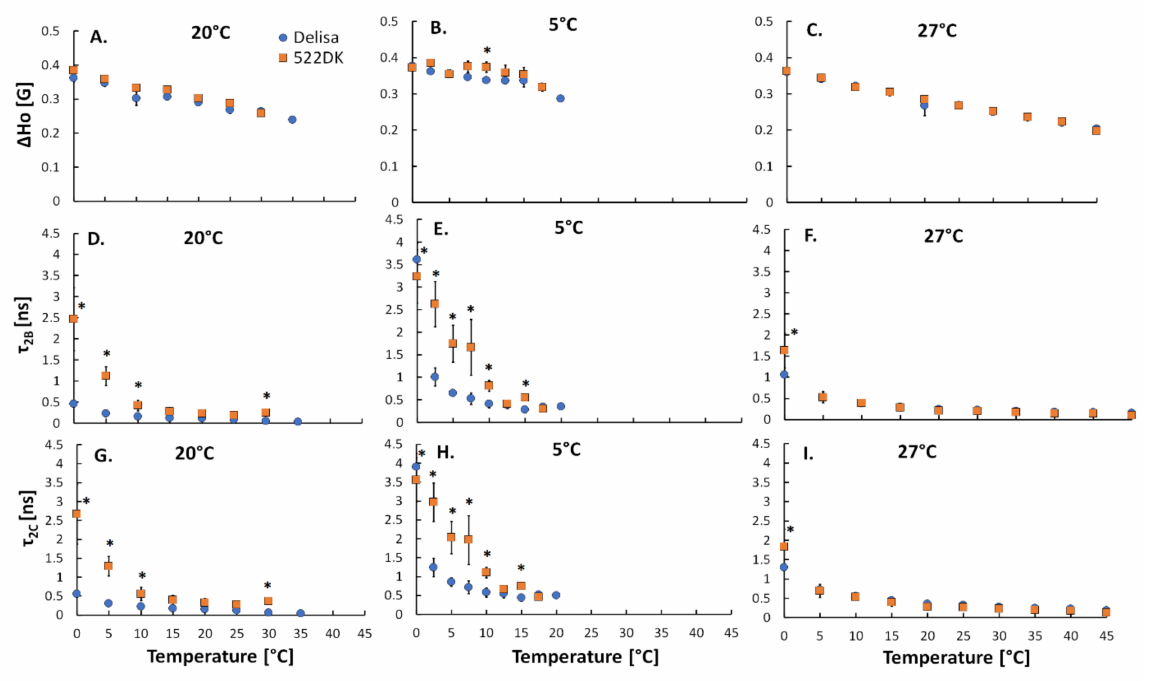
Figure 5. Dependence of parameters ∆ H 0 ( A – C ), τ 2B ( D – F ) and τ 2C ( G – I ), which were calculated for the chloroplast membranes that were isolated from the barley wild-type Delisa and its mutant 522DK with incorporated SASL-16 on temperature. Plants had been cultivated at 20 ◦ C and acclimated at 5 ◦ C and 27 ◦ C. Average data are given ± SE and significant differences between the wild type and mutant are indicated with an asterisk (*); comparisons were made separately for each EPR measurement